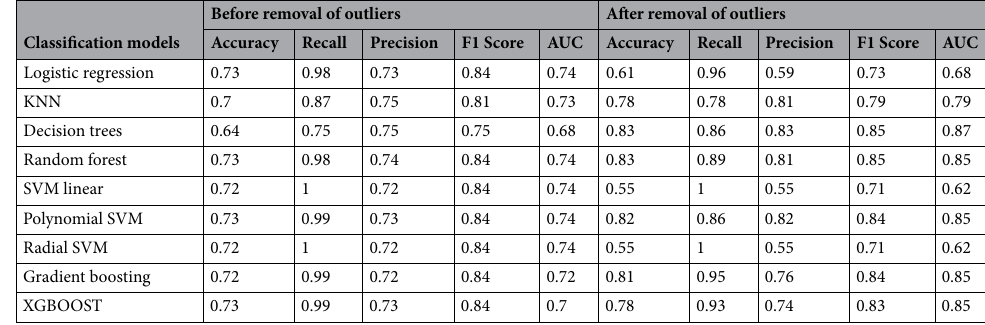
Table 4. Performance of various machine learning algorithms using blood profile data for the classification of Breast cancer metastasis. The table represents the comparative performance of ML models before and after the removal of the